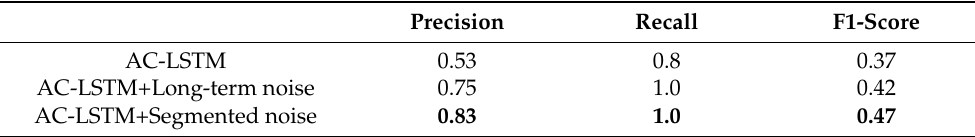
Table 2. The effect of different enhancement methods. (Long-term noise refers to the enhancement of all data once in the way of interpolation instead of window slicing, and segmented noise refers to the enhancement method of sliding window proposed in this paper.).